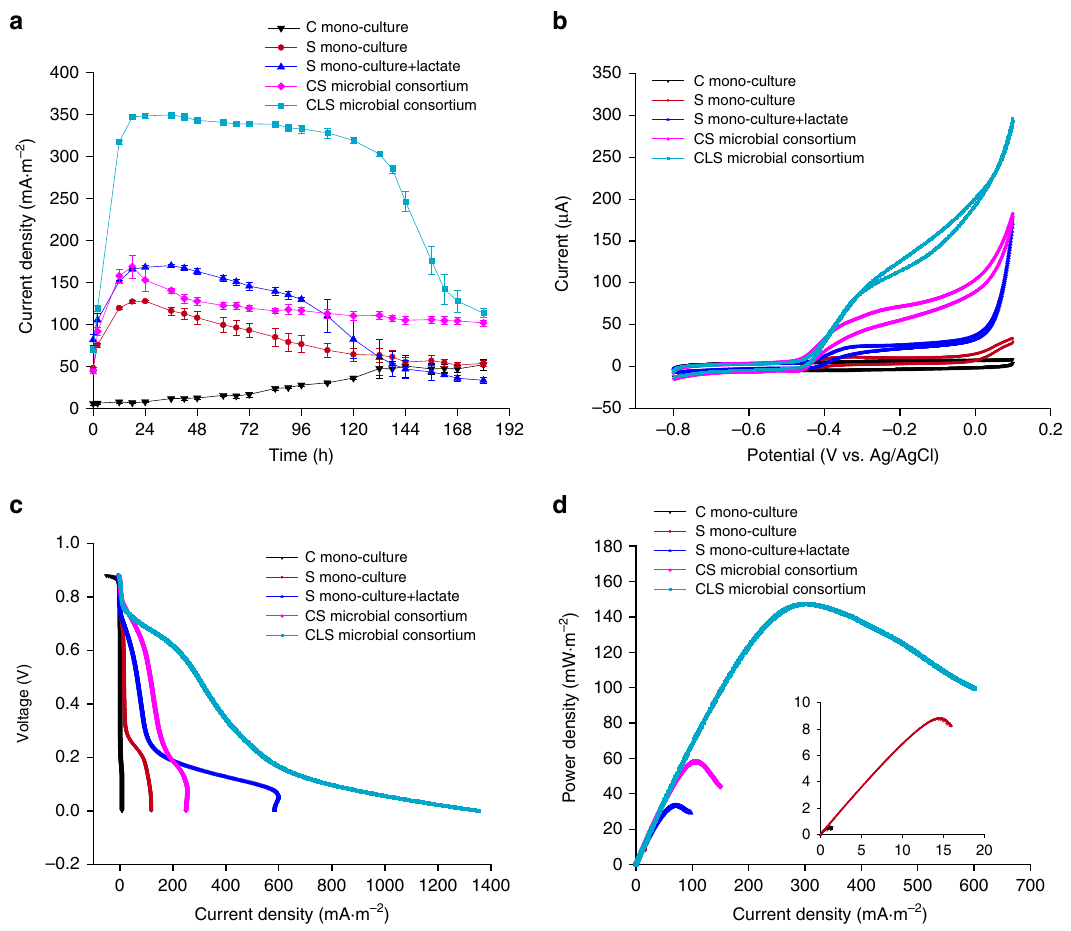
Fig. 4 Electrochemical characterization of the temporally separated microbial consortia. a Current density produced by the CLS microbial consortium and its counterparts. C mono-culture represents the mono-culture of Syn 2973- omcS - ldh , and S mono-culture represents the mono-culture of S. oneidensis- Δ napA . b Cyclic voltammetry (CV) at a low scan rate of 1 mV·s − 1 . c Polarization curves obtained from linear sweep voltammetry (LSV) with a low scan rate of 0.1 mV·s − 1 . The voltage in Y -axis represents the potential difference between the cathode and the anode. d Power curves derived from the polarization curves. Error bars represent the standard deviations from n = 3 independent experiments. Source data are provided as a Source Data fi le